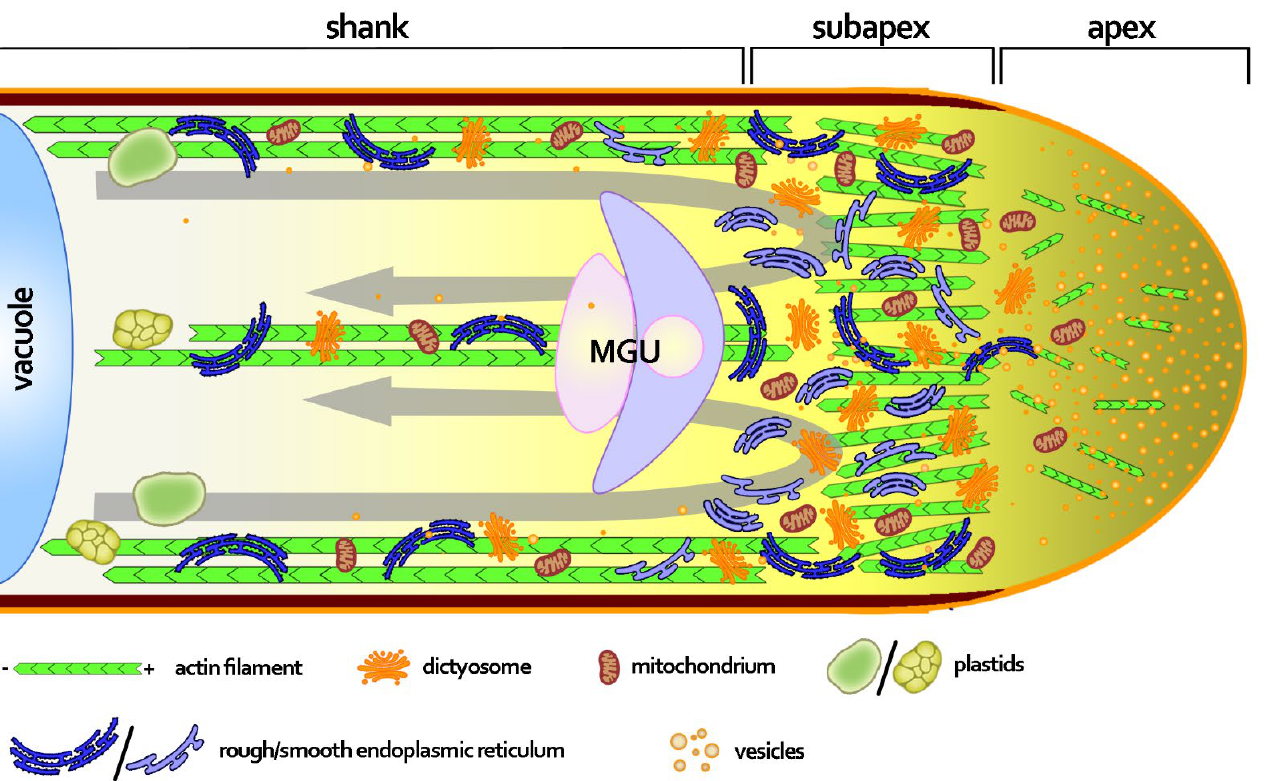
Figure 1. A schematic representation of the angiosperm growing pollen tube illustrating three distinct zones: apex, subapex, and shank. The apex is packed with transport vesicles and void of large organelles, leading to the formation of a “clear zone” with a network of fine and highly dynamic microfilaments. Behind the actin fringe at the subapical zone of the tube, F-actin forms strong actin bundles required for transport processes. Vesicles and organelles, such as mitochondria, endoplasmic reticulum (ER), and dictyosomes, are transported on cortical actin bundles towards the growing tip. Retrograde transport takes place on central actin cables, resulting in a “reverse fountain” pattern of cellular transport (grey arrows). Vesicles and small organelles are present throughout the pollen tube’s cytoplasm, but their highest concentration is in the subapical region. Large organelles, such as plastids and vacuoles, are localized in the shank. The biochemical composition of the pollen tube cell wall changes along the longitudinal axis; pectins predominantly form the primary cell wall at the tip, whereas further back the cell wall is composed of pectins, cellulose, and callose (brown) , which is absent from the apex, leading to increased stiffness of the shank’s cell wall . Yellow intensity from the apex to the shank illustrates the tip-focused calcium (Ca 2+ ) gradient in the pollen tube’s cytoplasm. MGU : male germ unit. Not to scale.